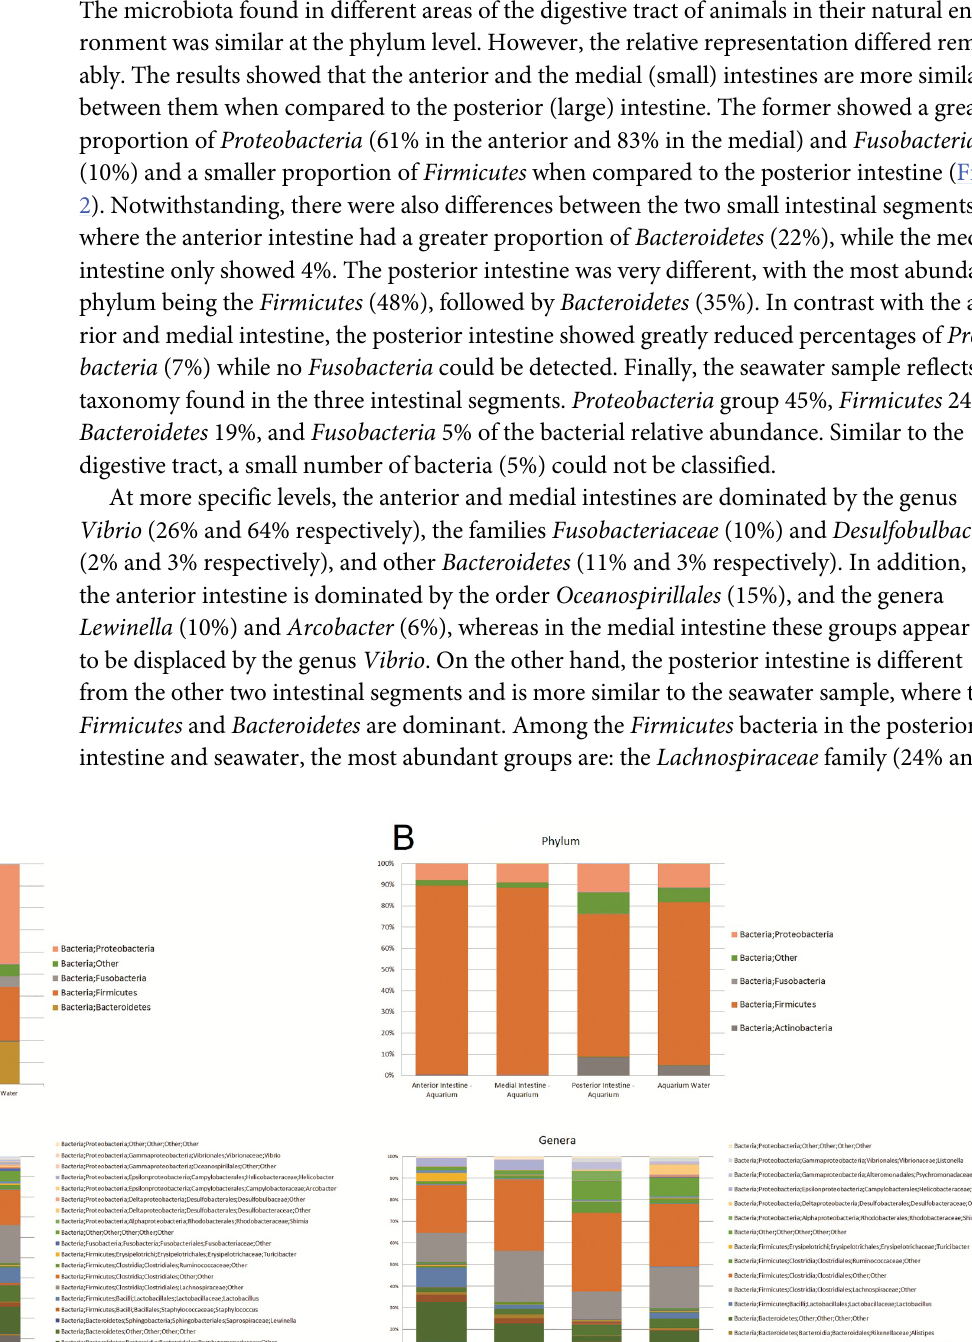
PLOS ONE | https://doi.org/10.1371/journal.pone.0208011 January 30,